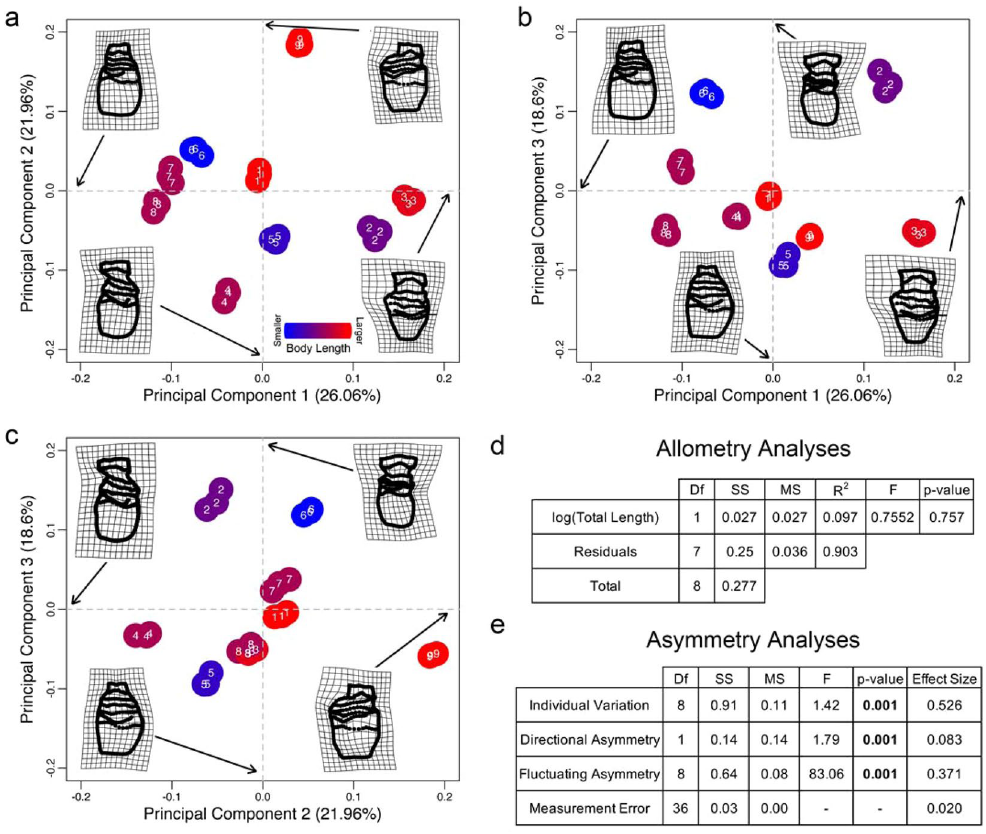
Figure 3. Principal component analysis of nine vaginas with three replicates each showing the variability of vaginal shape within the morphospace (visualized using thin-plate spline grids) comparing ( a ) PC1 and PC2, ( b ) PC1 and PC3, and ( c ) PC2 and PC3. Specimens are colored based on body length (hotter colors equal longer porpoises) showing a limited relationship between specimen body length and vagina shape. ( d ) Procrustes ANOVA of total body length and shape. ( e ) Asymmetry analyses showing p-values and effect sizes for the symmetric component of variation (individual variation), directional asymmetry, fluctuating asymmetry, and measurement